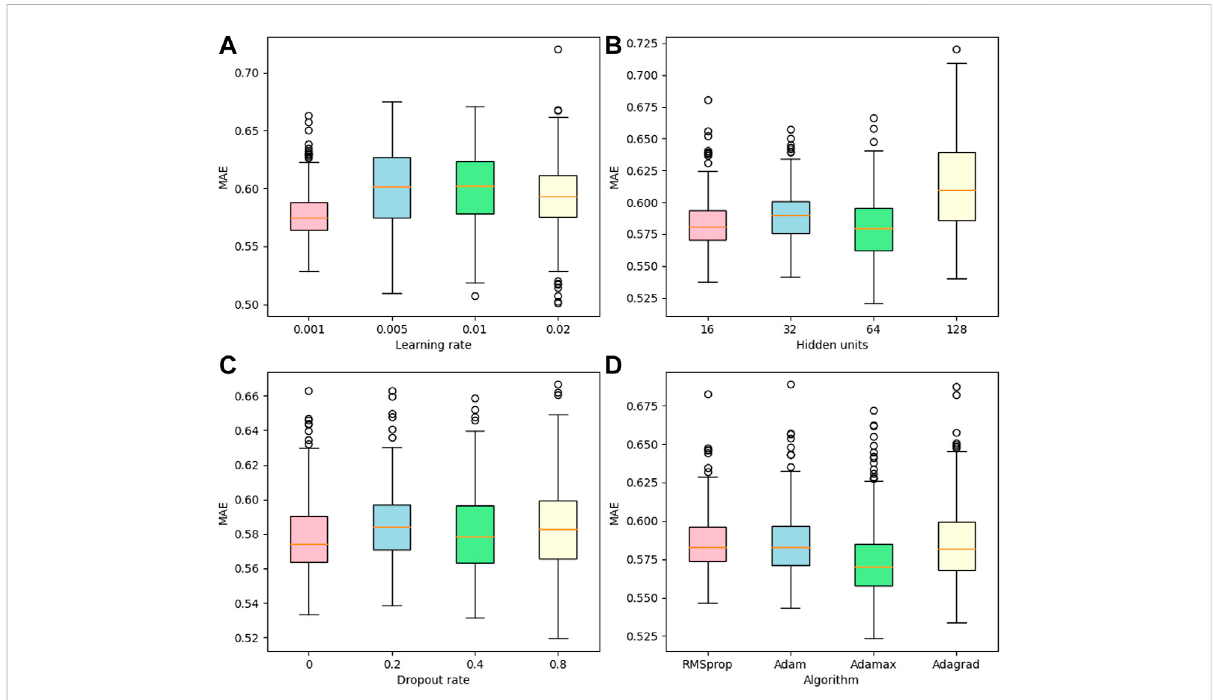
FIGURE 7 Boxplot.ThemodelistrainedusingthewellAdata,andthenetworkhyperparametersareadjustedaccordingtotheMAEvaluesofthevalidation set. (A) learning rate, (B) hidden units, (C) dropout rate, (D) algorithm.